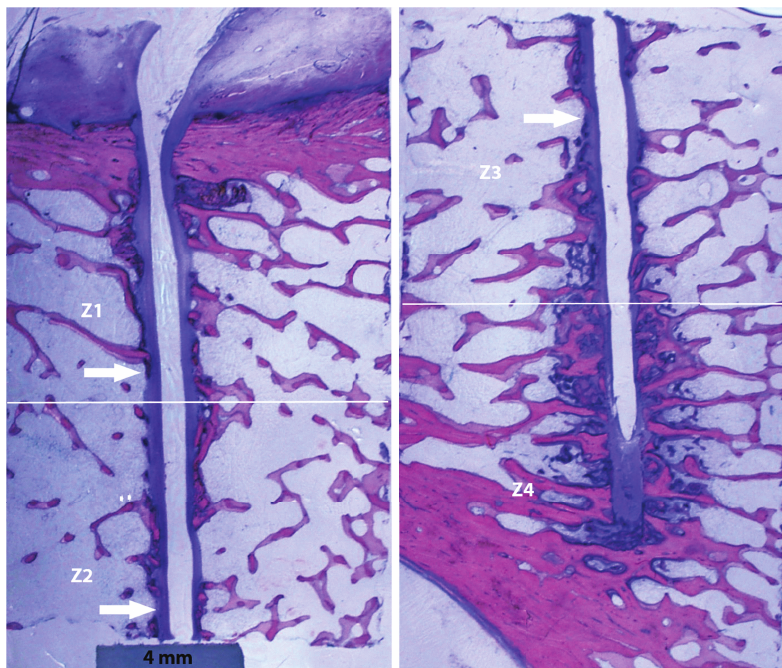
Figure 3: Low-magnification picture of histological section where it is evident the fibrous tissue around the implant (arrows). Scale bar represents 4mm.